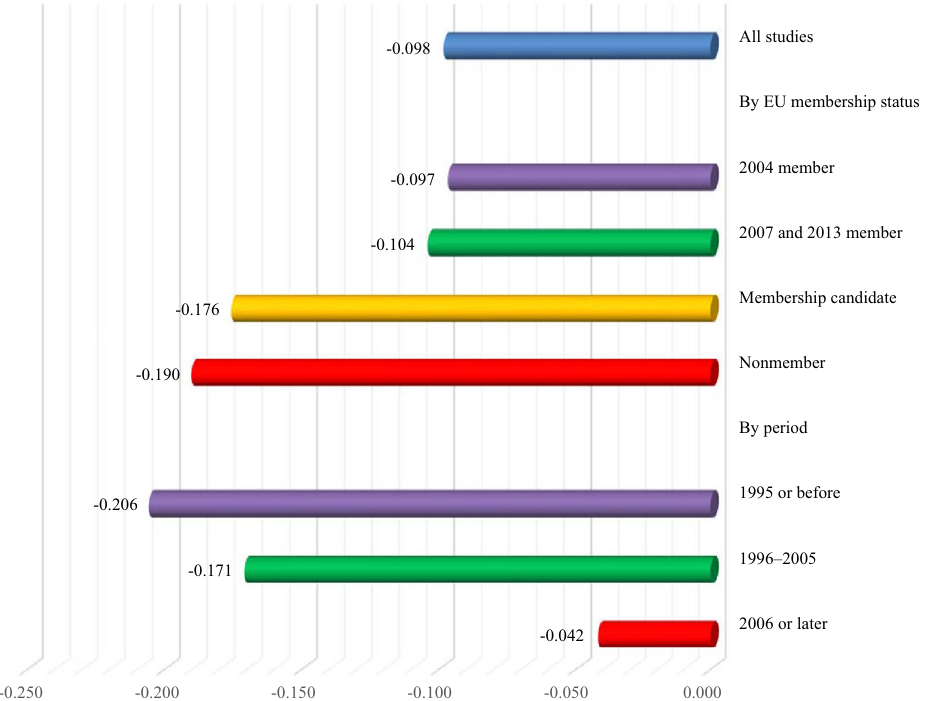
Fig. 2 Illustrated comparison of synthesis results. This figure illustrates the synthesized effect size by WAAP estimation reported in Table 2 using estimates of the gender dummy variable reported in 53 research works listed in Additional file 1: Table S1 and Additional file 2: Bibliography of studies subject to meta-analysis. See Table 1 for the descriptive statistics of